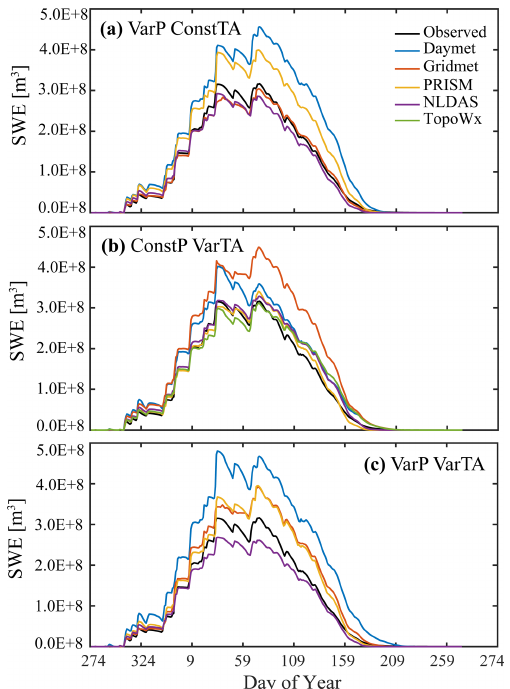
Figure 6. Daily SWE from the reanalysis product (black lines) as well as the range of simulated SWE from each of the three ex- periments (a) VarPConstTA, (b) ConstPVarTA, and (c) VarPVarTA (color lines) in